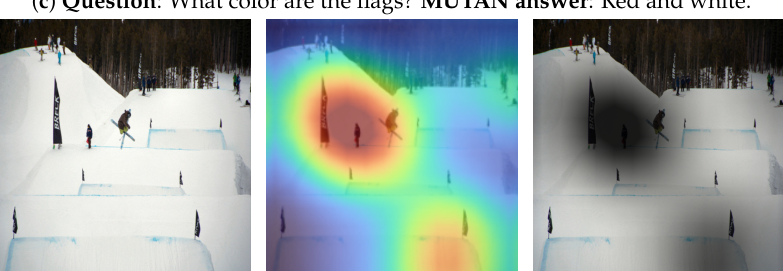
Figure 5. Example outputs of the Grad-CAM algorithm applied to MUTAN for color-based questions. Left: original image. Center: Interpolated attention map projected on the original image. Right: The background